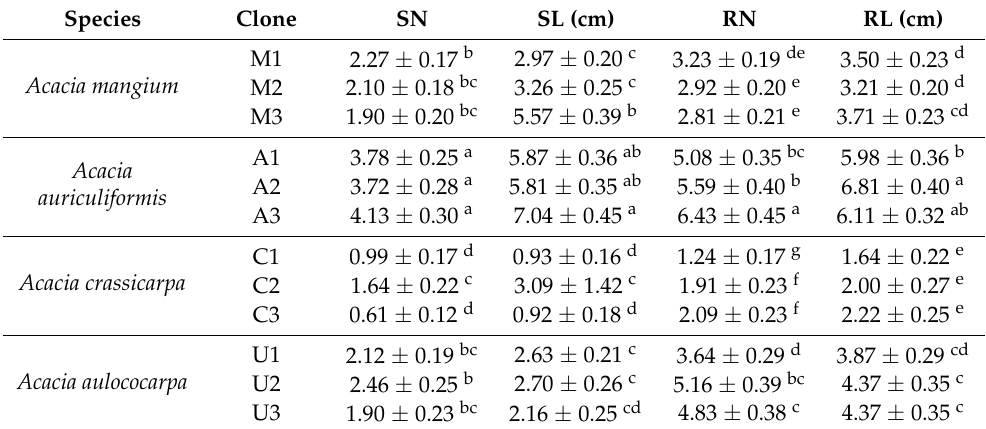
Table 5. Mean values of some rooting ability traits of cuttings of four Acacia species clones.